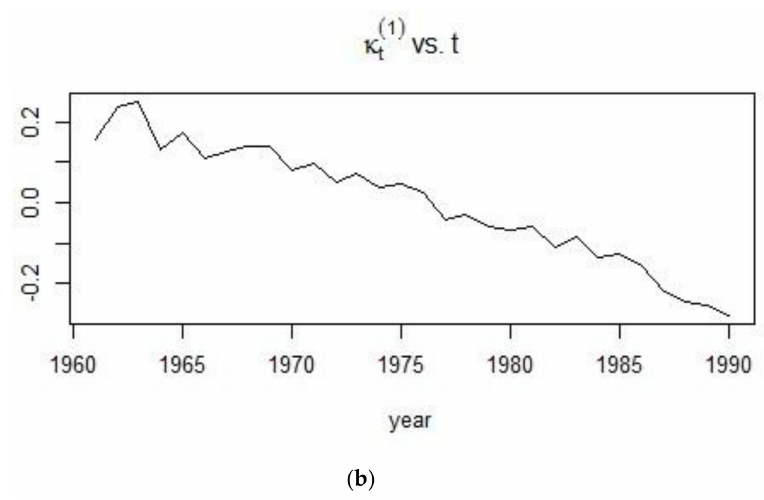
Figure 5. The evolution of the APC model mortality index during the ( a ) 1900–1938 period and ( b ) 1961–1990 period.